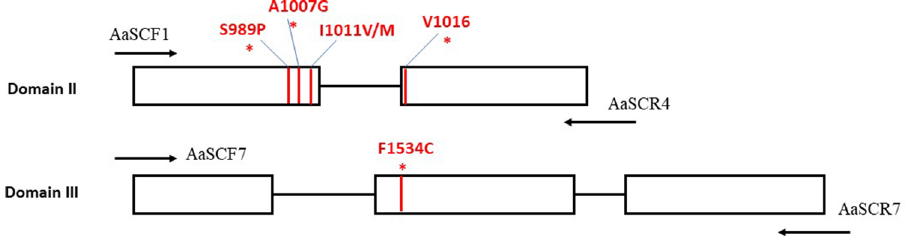
Figure 2. The kdr mutations (red lines) and primers (arrows) are indicated in the partial genomic region encoding Voltage-gated Sodium Channel (VGSC). Primer AaSCF1 and AaSCR4 were used to amplify VGSC domain II, meanwhile primers AaSCF7 and AaSCR7 for domain III. The four kdr mutations of S989P, A1007G (a new novel mutation), V1016G dan F1534C were found in the Selangor, Malaysia strain marked by red asterisks.